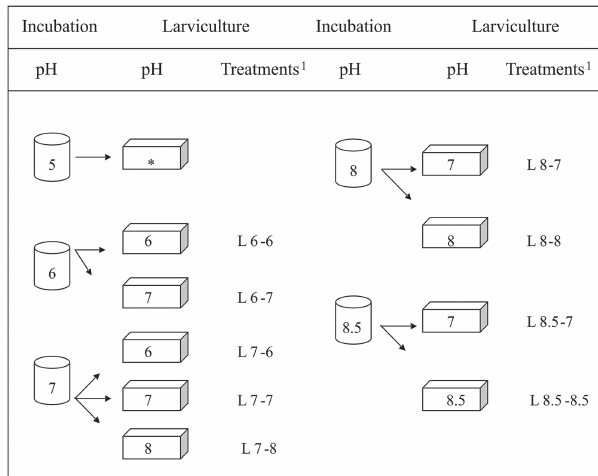
Table 1. Average values ± standard deviation of the fertilization and survival rates during the incubation of ‘curimbatá’ Prochilodus lineatus . 1 Different letters in the columns indicate statistical difference in the averages by the Tukey test (P < 0.05). *Fertilization Rate was